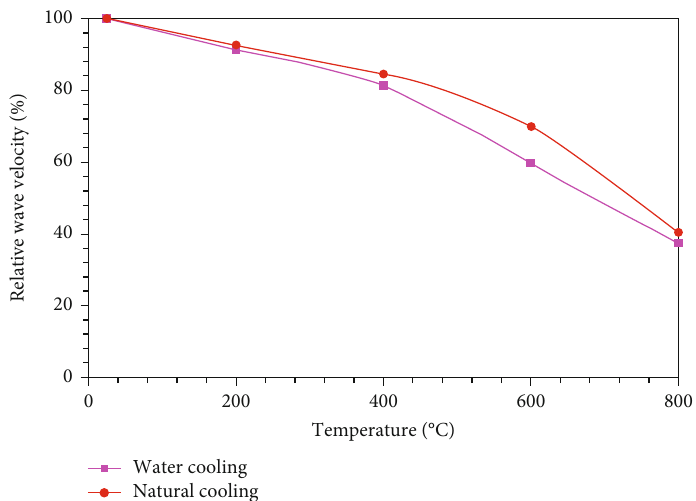
Figure 3: The variations of relative wave velocity of core samples with temperature under two di ff erent cooling methods.